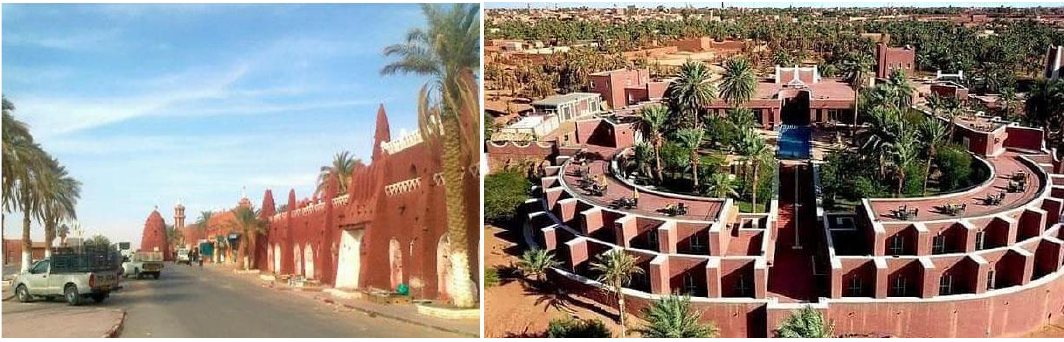
Figure 5 Comparison of colonial(left) and modern(right) archetypes of tourist complexes in Timimoun.